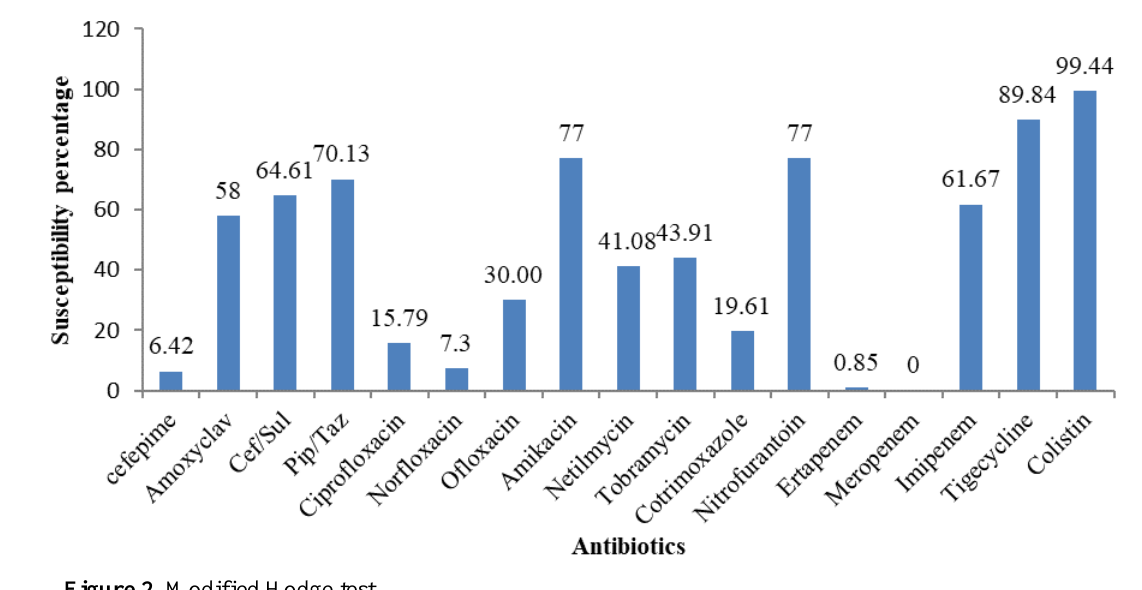
Figure 2. Modified Hodge test.